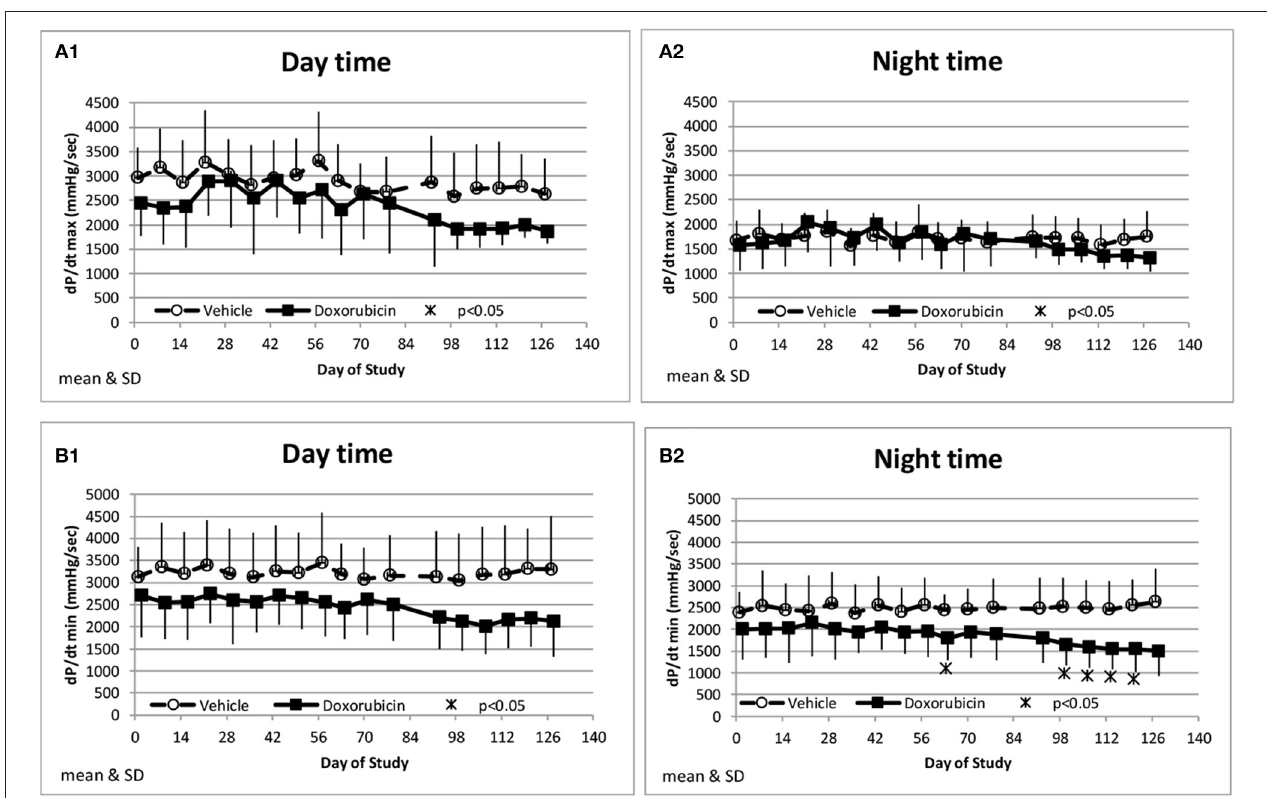
FIGURE 4 | Measurements of indices of cardiac contractility. Changes in dP/dtmax during the day and night cycle times (A1,A2) , and dP/dtmin (B1,B2) averaged over the day and night time frames over the course of the